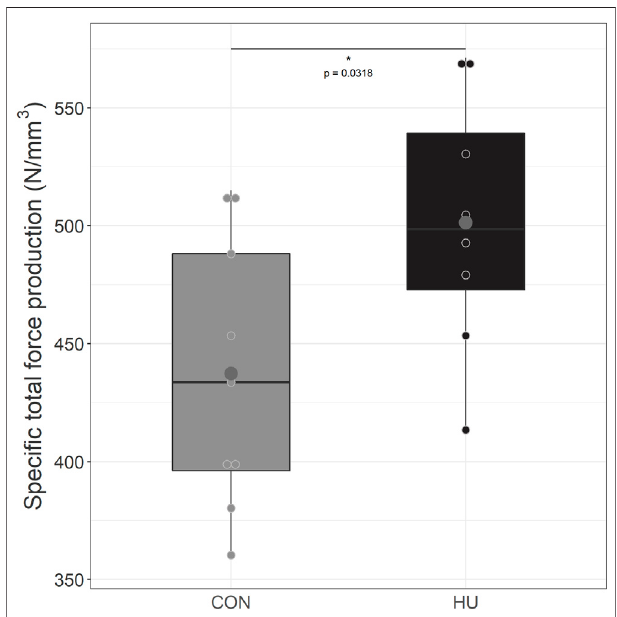
FIGURE 4 | Speci fi c total force production from during the 6 minutes moderate exercise in CON (grey, n = 9) and HU (black, n = 8) groups, results are presented in boxplot. * signi fi cantly different from HU